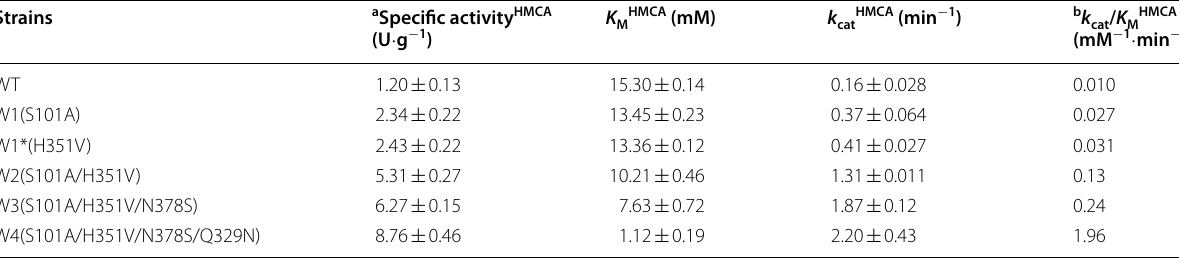
a The specific activity of CHDA was determined with 10 μM purified Ac CO (WT) or its variants and 5 mM HMCA in 1 mL air-saturated potassium phosphate buffer (100 mM, pH 8.0) at 30 °C for 30 min b The k cat / K M values of CHDA was determined with 10 μM purified Ac CO (WT) or its variants and 1–100 mM HMCA in 1 mL air-saturated potassium phosphate buffer (100 mM, pH 8.0) at 30 °C for 30 min Table 2 Kinetic constants of Ac CO and its variants in production of HMCA